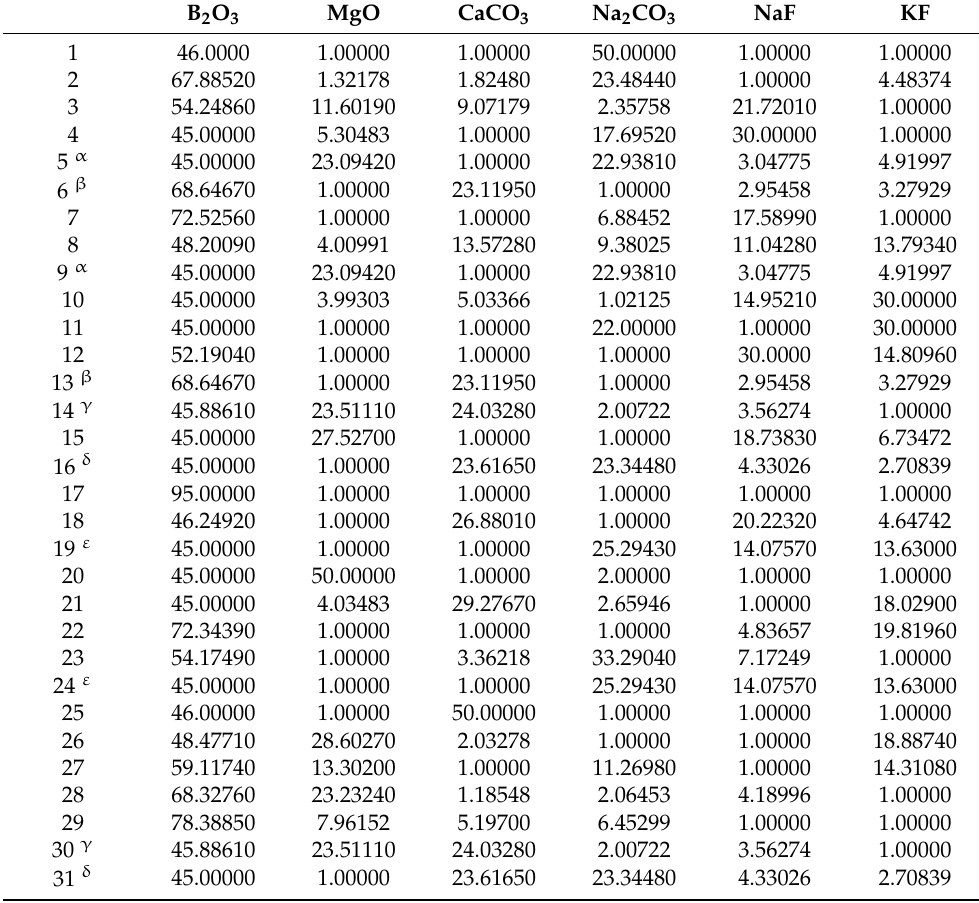
Table 2. Compositions of the 31 investigational glasses, denoted in molar % as identified by the design of mixtures outlined in Table 1 (repeated compositions demoted by matching Greek